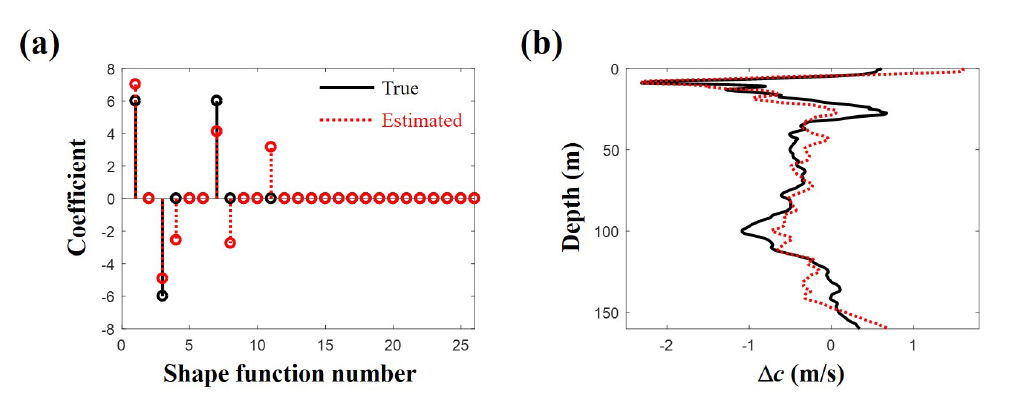
Figure 9. ( a ) actual activated components (solid line) among the 26 empirical orthogonal functions in sound speed profile dictionary and estimated components (dotted line) from the compressive sound speed profile estimation; ( b ) the sound speed differences along depth from the reference sound speed profile. The solid and dotted lines are actual and reconstructed values, respectively.